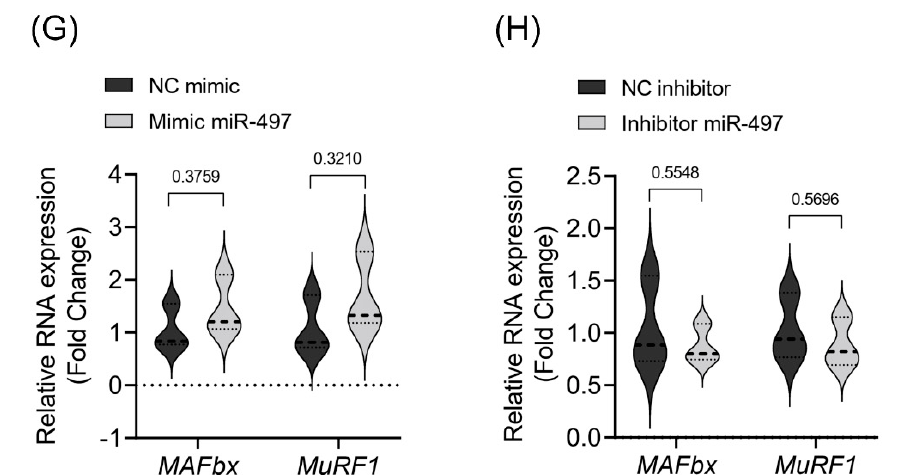
Figure 4. miR-497-5p effects in differentiated C2C12 myotubes. ( A ) Relative log10 transformed miR-497-5p levels measured by RT-qPCR in C2C12 myotubes transfected with mimic miR-497-5p, compared to C2C12 myotubes transfected with mimic control. ( B ) RT-qPCR showing decreased expression of miR-497 in C2C12 myotubes transfected with miRNA inhibitor against miR-497-5p. ( C ) Representative images of myotubes transfected with negative control or with miR-497-5p mimic. The immunofluorescence was performed using the antibody against Myh2 (red) and Dapi (blue). ( D ) Diameter of myotubes transfected with negative control or miR-497-5p mimic. ( E ) Representative images of myotubes from the negative control or transfected with miR-497-5p inhibitor. ( F ) Diameter of myotubes transfected with negative control or miR-497-5p inhibitor. Cells 2021 , 10 , x FOR PEER REVIEW ( G ), mRNA levels of atrogenes MAFbx and MuRF1 C2C12 myotubes transfected with mimic miR-497-5p and ( H ) in C2C12 myotubes transfected with miRNA inhibitor against miR-497-5p. Statistical difference was analyzed by Student’s t -test.